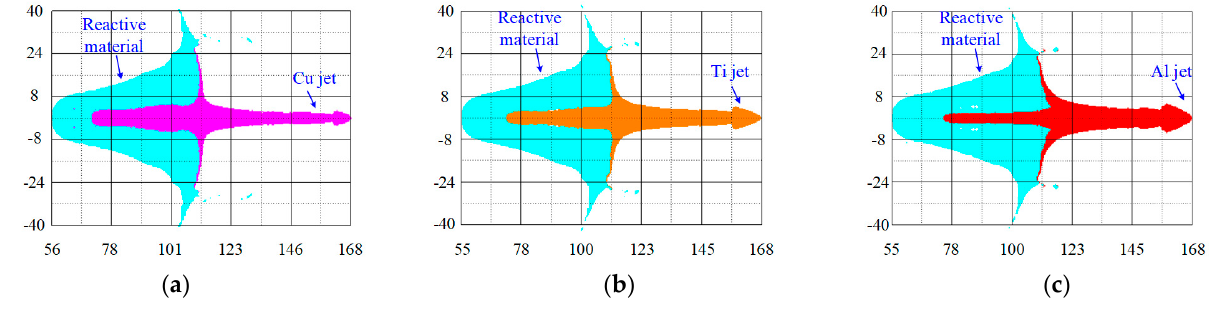
Figure 10. Formation morphology of composite jets before impacting the targets: ( a ) reactive material–Cu jet; ( b ) reactive material–Ti jet; ( c ) reactive material–Al jet.